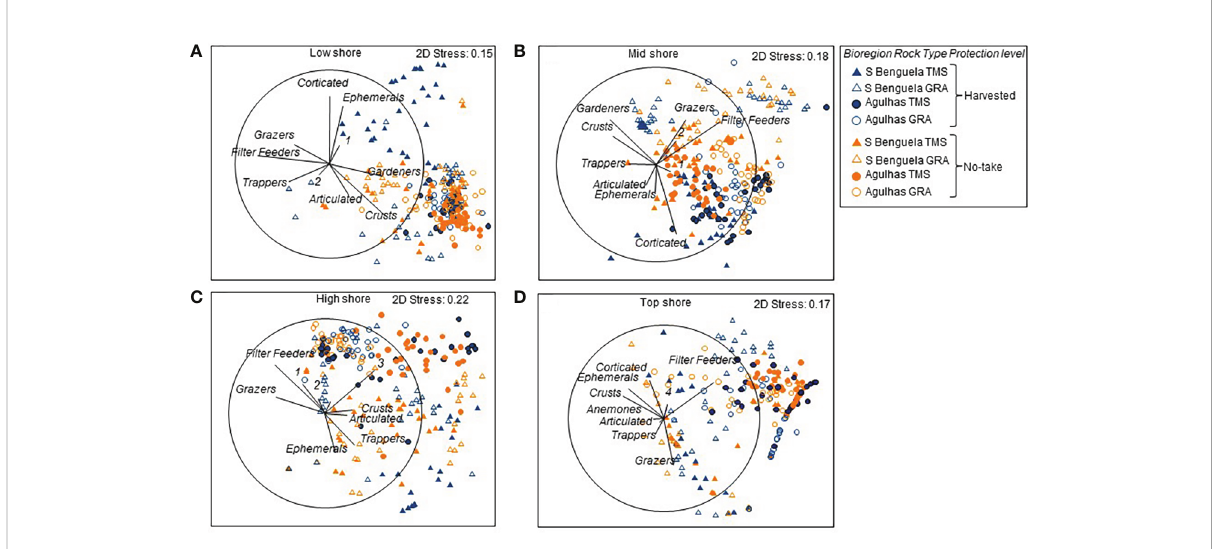
FIGURE 5 MDS plots showing differences in community composition among quadrats re fl ecting the effects of Protection, Ecoregion and Rock type for (A) low, (B) mid, (C) high and (D) top zones of 16 sites within the Table Mountain national `park MPA, which spans the Southern Benguela (S